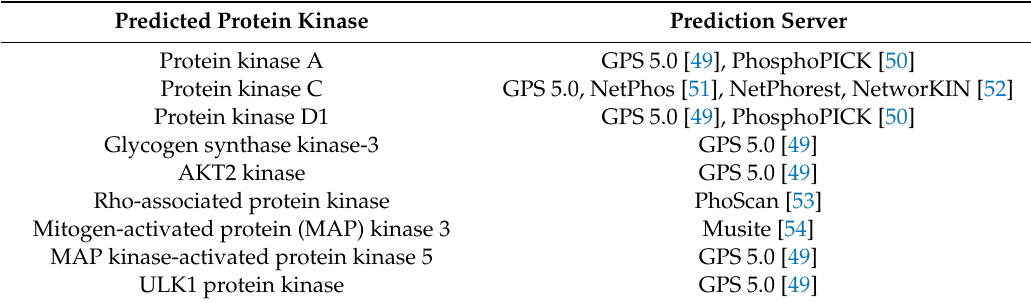
Table 1. Protein kinases predicted at a high or medium stringency level / threshold to phosphorylate human Transient Receptor Potential Ankyrin 1 (TRPA1) at